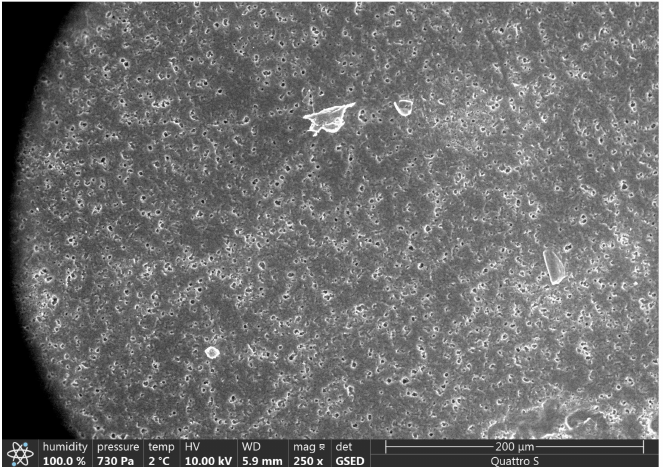
Figure 5. Illustration showing the magnification of Product G (250 × ). Multiple insoluble particles were